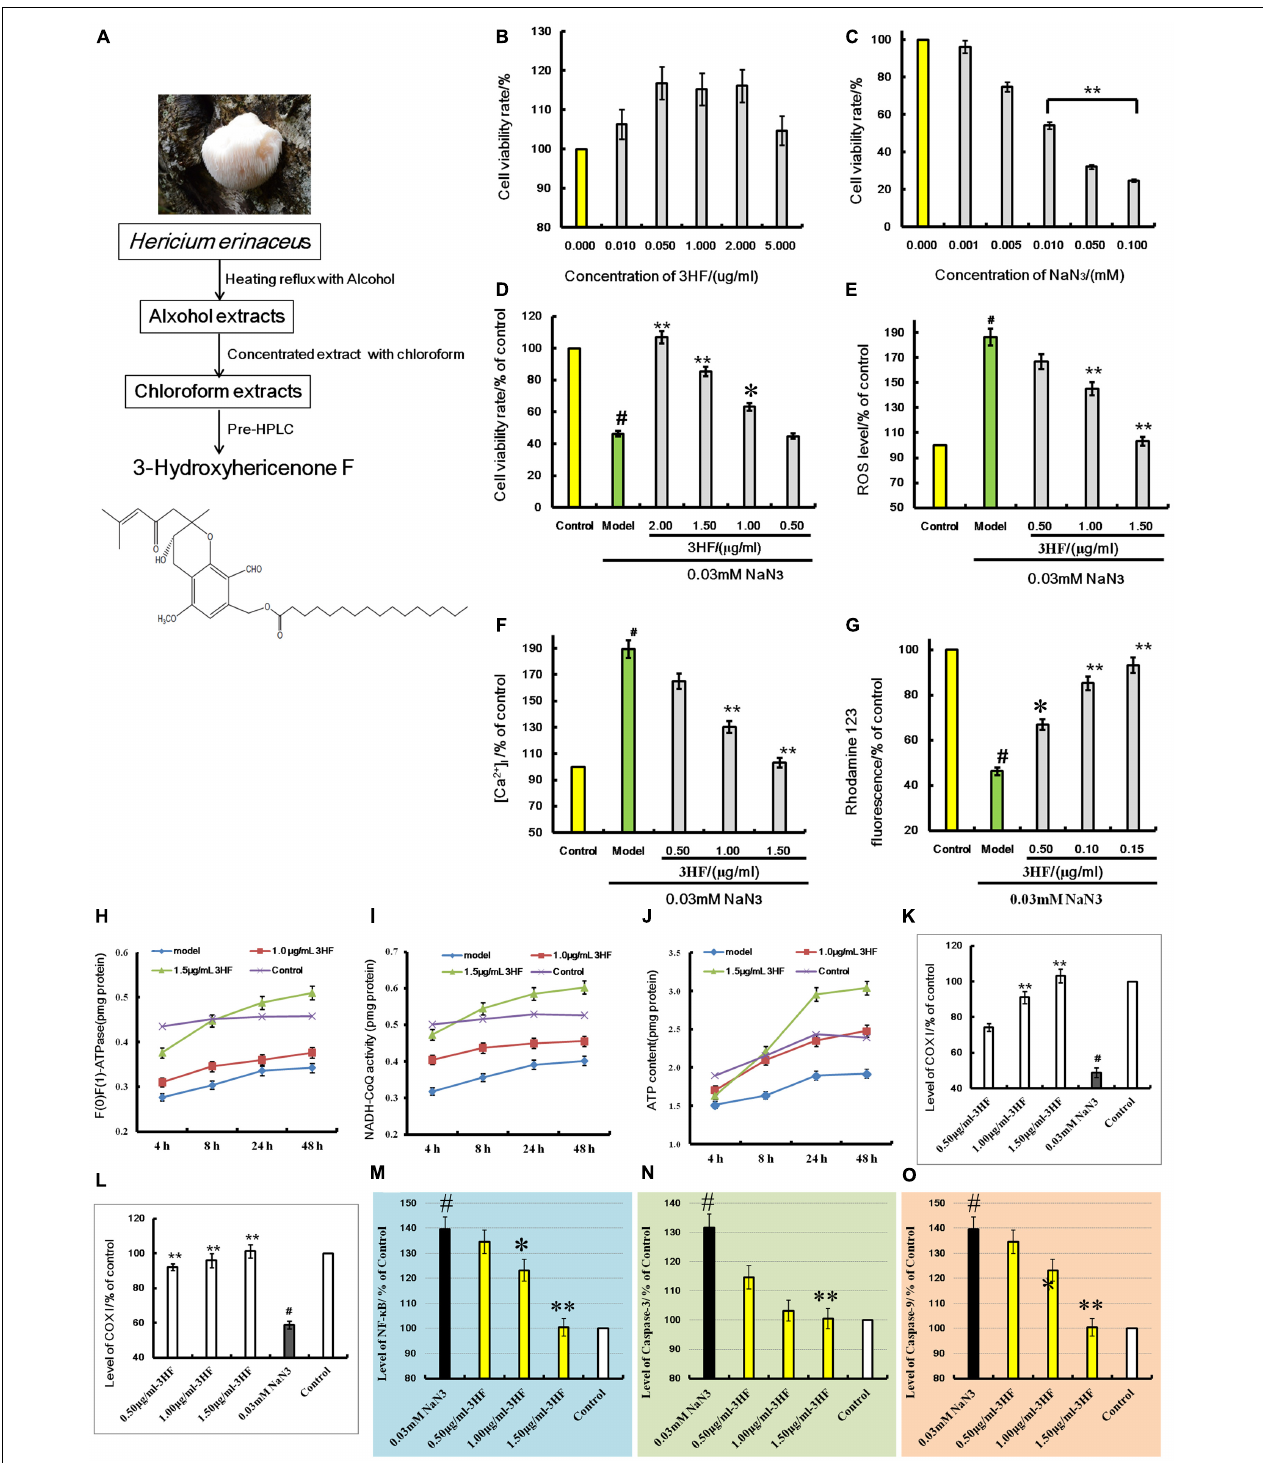
FIGURE 5 | (A) is the extraction flowchart and chemical structure of 3HF. Effects of 3HF and NaN 3 on PC12 cells (B–D) and effect of 3HF on ROS (E) , [Ca 2 + ] i (F) , mitochondrial membrane potential (G) , F ( 1 ) F ( 0 ) -ATPase (H) , NADH-CoQ (I,J) , COX I (K) , COX II (L) , NF- κ B (M) , Caspase-3 (N) , and Caspase-9 (O) in NaN 3 -induced cytotoxicity PC12 cells. The cells were pretreated with 3HF at the concentrations of 0.05, 1.00 and 1.50 µ g/ml for 2 h, followed by exposure to 0.03 mM of NaN 3 for 24 h, whereas the control group was treated with PBS. Values are provided as the mean ± SD ( n = 5) and % of the control group, # p < 0.01 compared with control group; ∗ p < 0.05 and ∗∗ p < 0.01 compared with the NaN 3 -treated group, indicates significant differences compared with the model group.